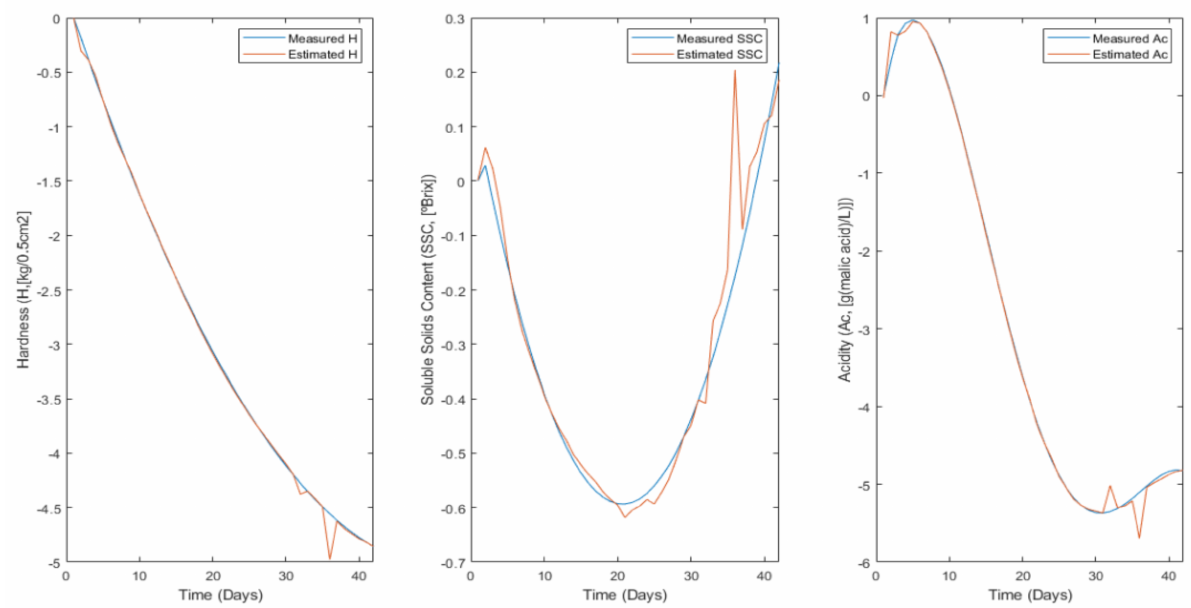
Figure 6. Results of the parameters measured in the tests and estimated by the neural network. The ANN decision support system was tested on a sample in which the initial param- eters were: hardness: H = 5.07 (kg/0.5cm 2 ); acidity: Ac = 8.16 (g malic acid /L); and soluble solids content: SSC = 10.63 ( ◦ Bx). The average conservation parameters for each farmer are shown in Table 4. Table 4. Average conservation parameters (T and HR) of the different farmers. Parameters of